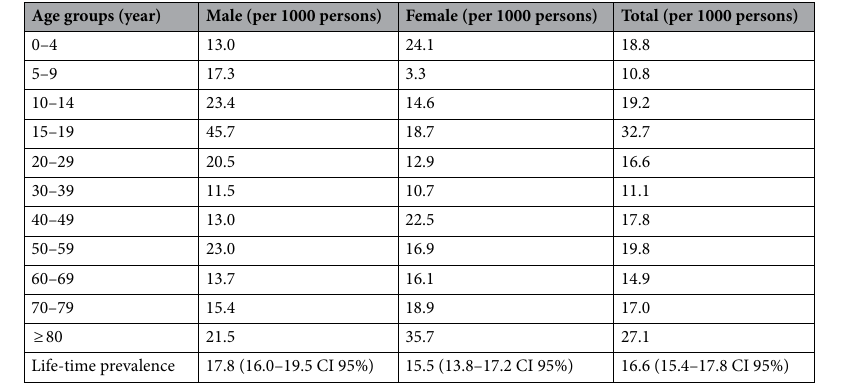
Table 2. Correlations between sex and age of participants on the life time